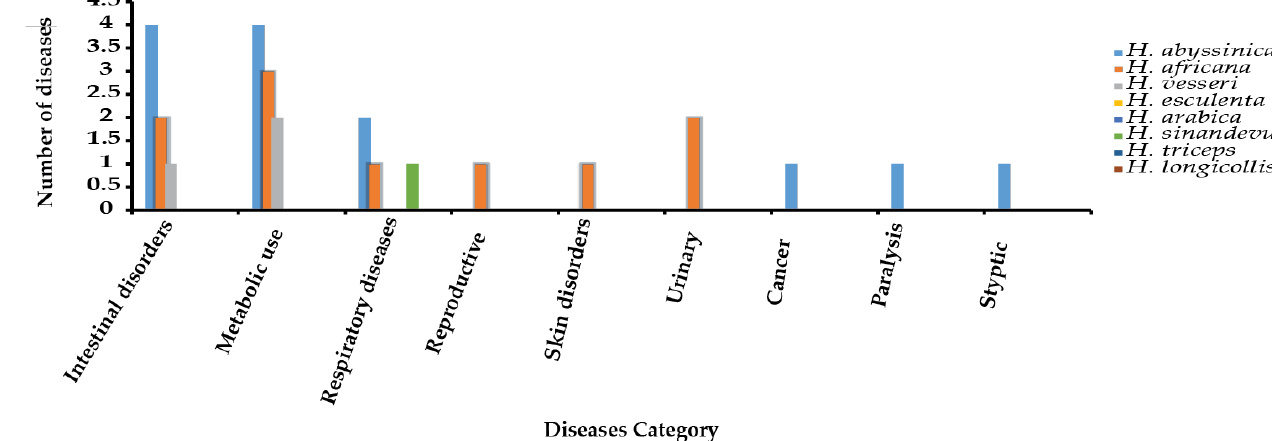
Figure 5. Diseases treated using Hydnora species in Africa and the Arabian Peninsula .